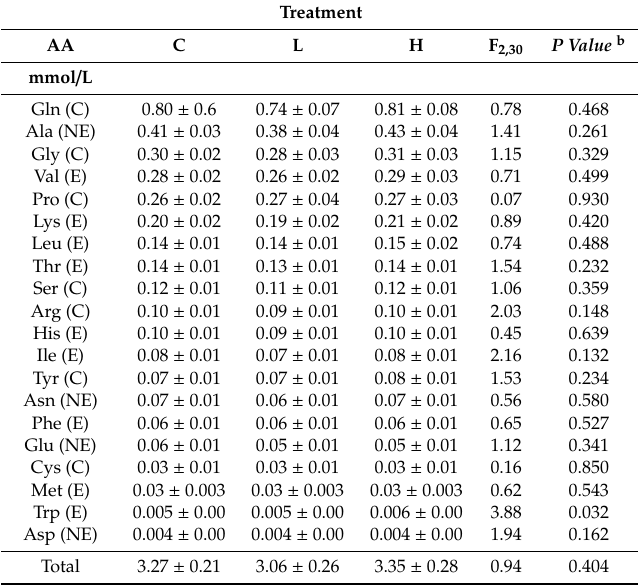
a Data are means ± SEMs, n = 16; amino acids (AAs) have been presented in order of highest to lowest concentration. b Main e ff ect of protein load was determined by one-way repeated measures ANOVA; statistical significance